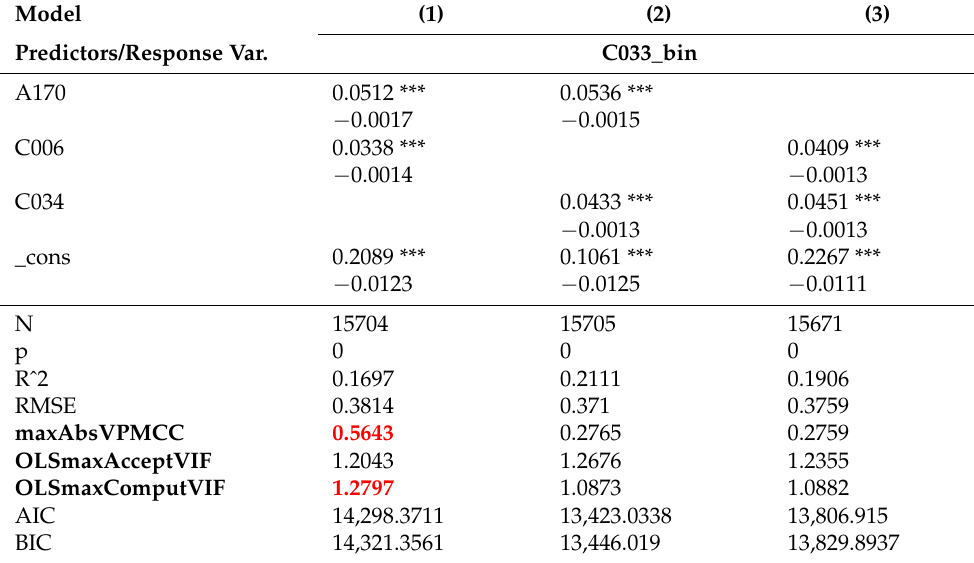
Table A4. Collinearity checks using ordinary least squares regressions for job satisfaction and each pair of the 3 remaining predictors (1st column, Table A3, Appendix